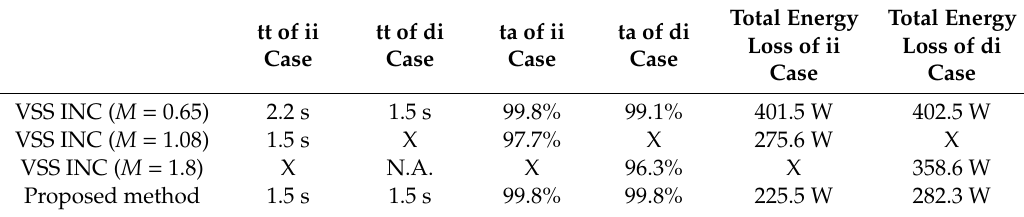
Figure 10. Experimental results of different M values ( a ) M = 0.65, ( b ) M = 1.8, ( c ) M = 0.65/1.8. Table 5. Summarized experimental results of different M values.